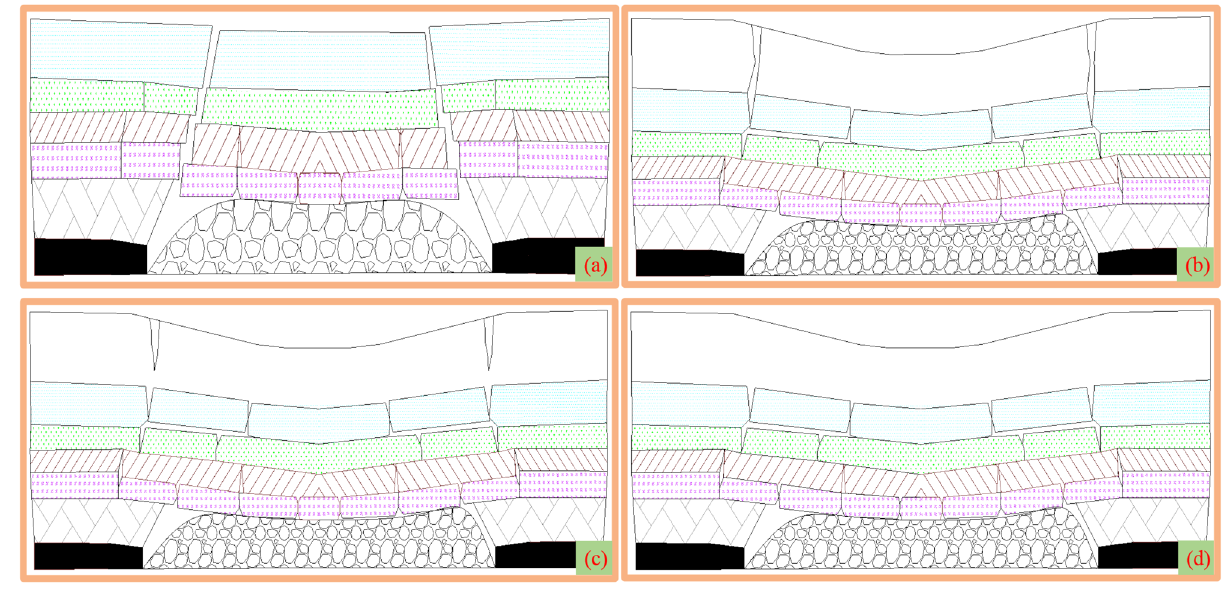
Figure 16. Damage assessment types of high-intensity mining. ( a ) H 1 > H . ( b ) H 1 + H 2 = H . ( c ) H 1 + H 2 < H . ( d ) H